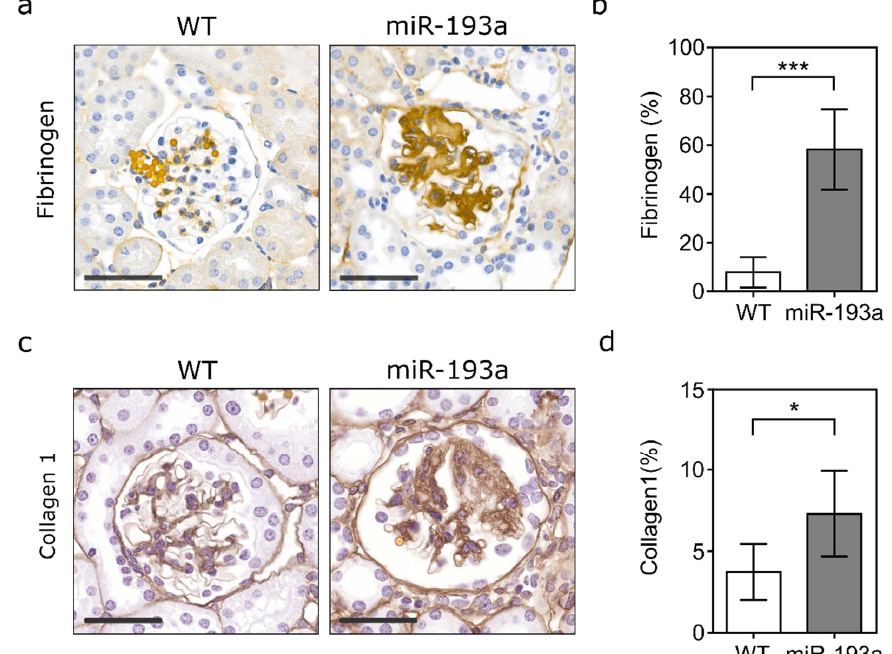
Figure 2. Fibrinogen and collagen 1 in a kidney glomerular matrix. ( a ) Representative images of FFPE sections stained for fibrinogen. ( b ) Fibrinogen-positive area in % of total glomerular tuft area in wild-type control (WT) versus FSGS mice 8 weeks post miR-193a induction. ( c )